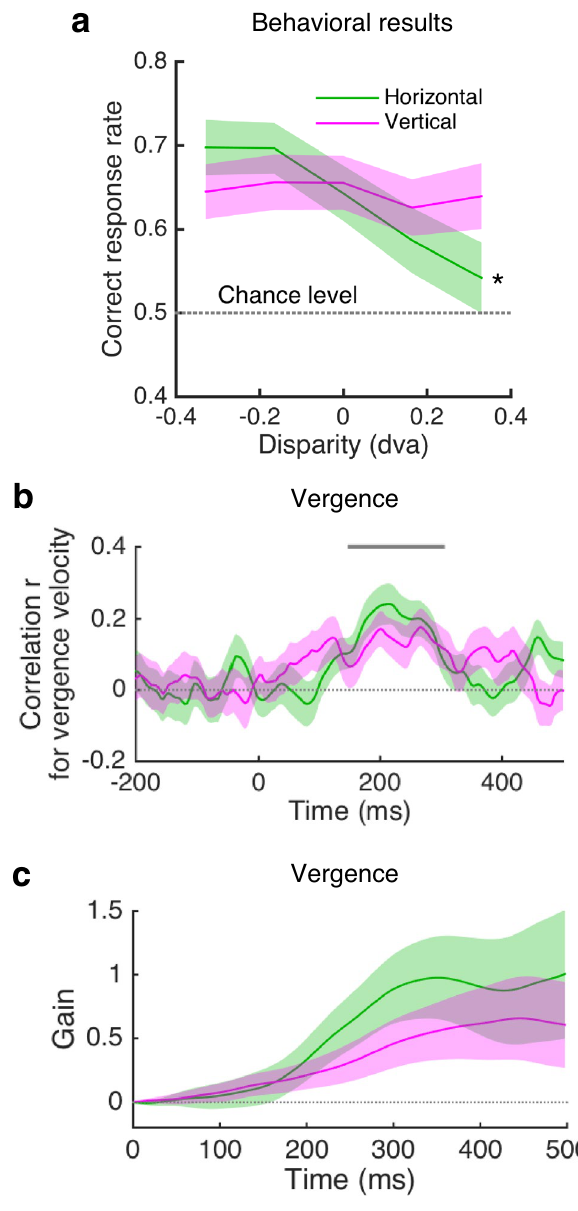
Figure 2. Behavioral and eye movement results ( n = 29). ( a ) Behavioral performance for slant discrimination in the horizontal and vertical disparity conditions. ( b ) Mean correlation coefficients for vergence velocity averaged over the 29 subjects calculated as a function of time. The horizontal gray bar indicates the interval in which correlation was significantly greater than 0 in the horizontal or vertical disparity condition (150–314 ms; p s < 0.05, corrected). ( c ) Mean gain of vergence eye movement relative to stimulus disparity calculated as a function of time. A gain value of 1 indicates the eye position where the two eyes counteract the stimulus disparity perfectly. Color-shaded areas represent the standard errors of the mean